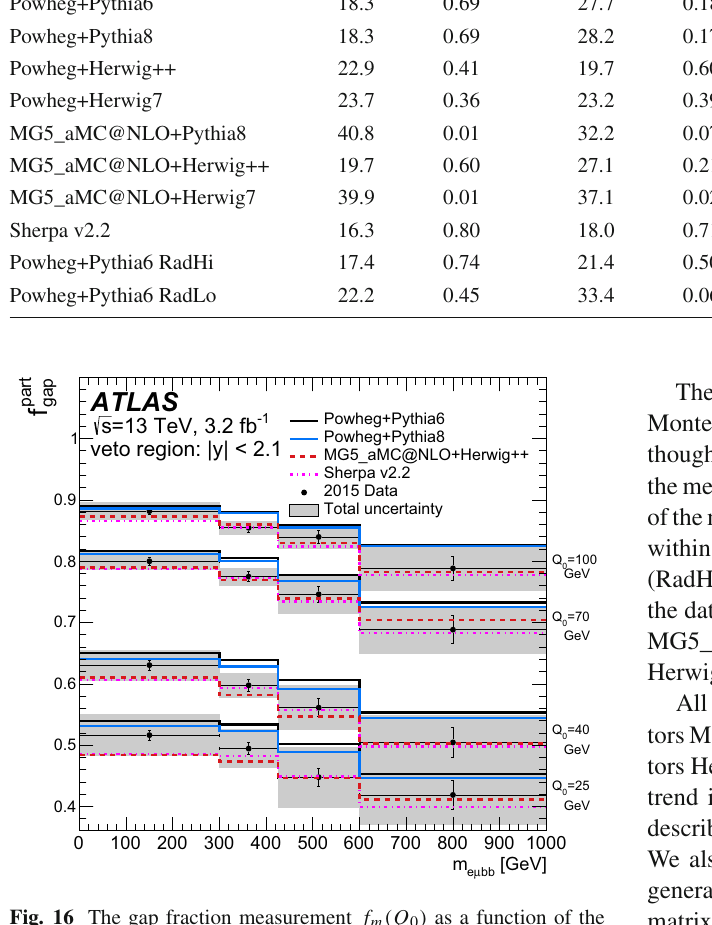
Fig. 16 The gap fraction measurement f m ( Q 0 ) as a function of the invariant mass m e μ bb , for several different values of Q 0 . The data are shown as points with error bars indicating the statistical uncertainties and shaded boxes the total uncertainties. The data are compared to the predictions from various t ¯ t simulation